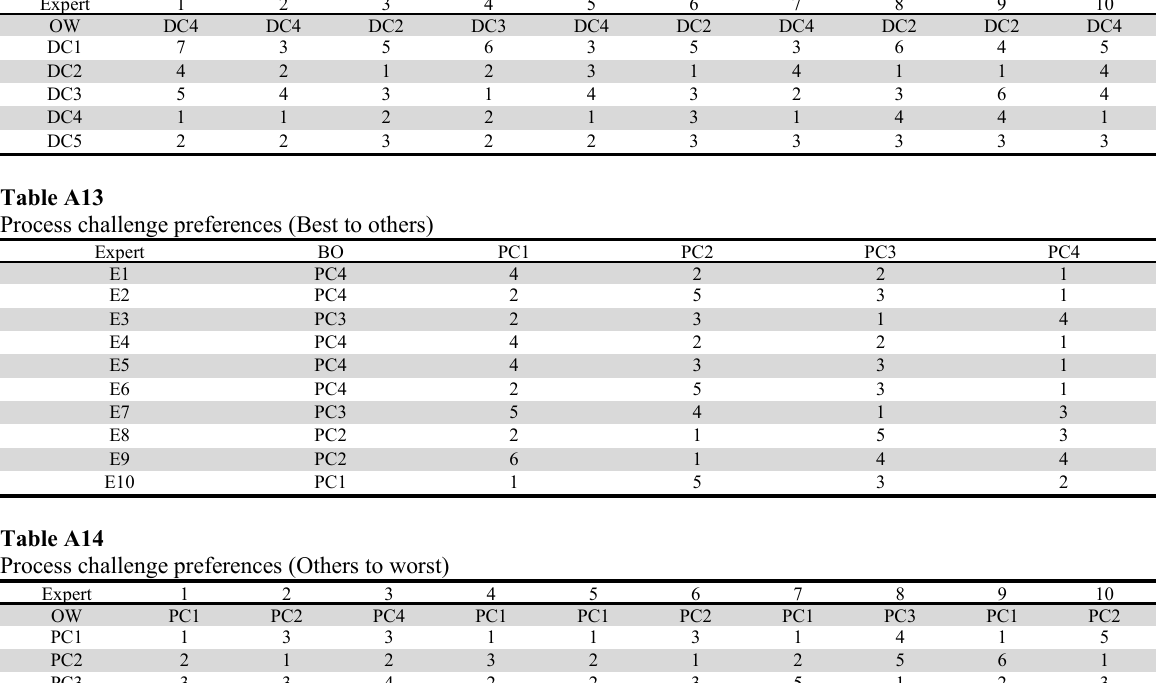
Data challenge preferences (Others to worst) Expert